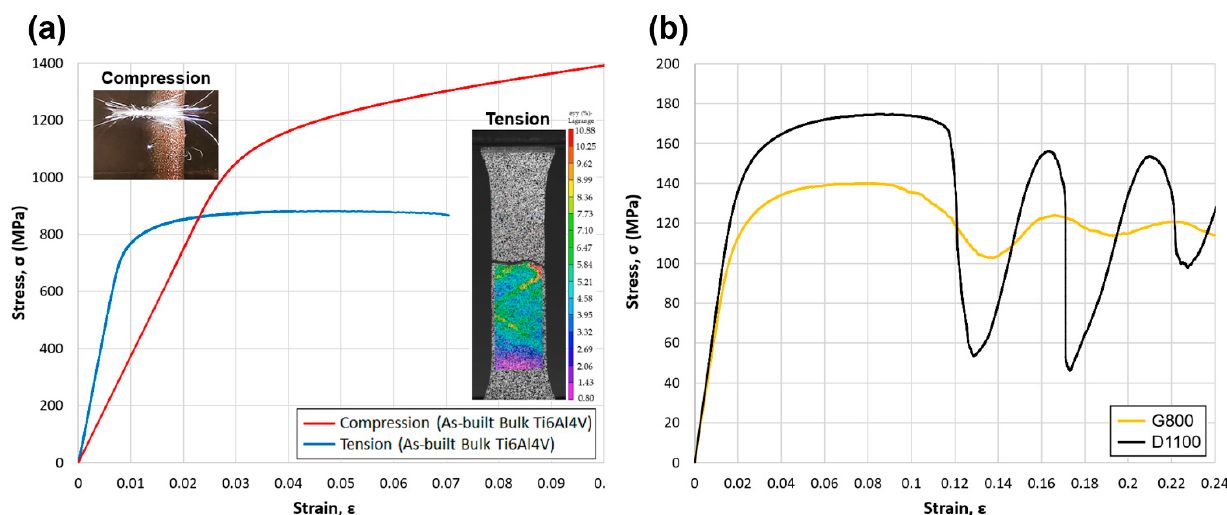
Figure 9. ( a ) Compression and tension stress–strain behaviour of bulk additively manufactured Ti6Al4V. Colour scale shows the surface Lagrange strain ( b ) Compression stress–strain behaviour of G800 and D1100 scaffolds.